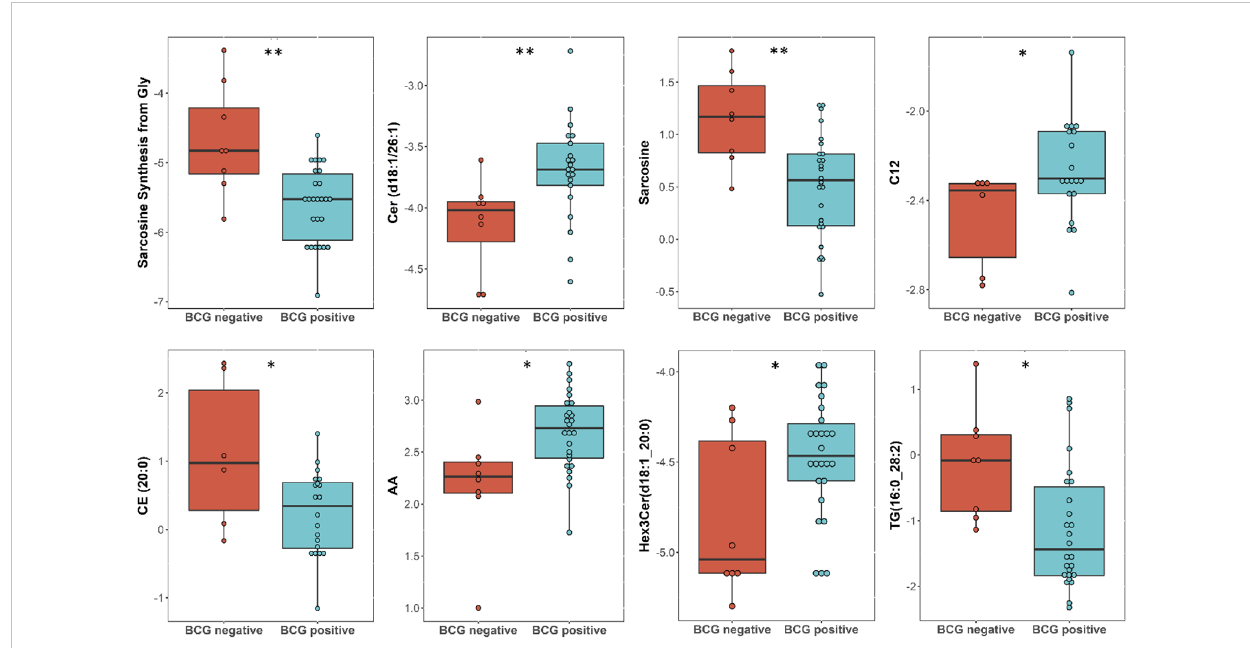
FIGURE 3 Metabolites associated with BCG vaccination in T2D patients with different levels of COVID-19 severity. **/* signi fi es <0.01/<0.05 p